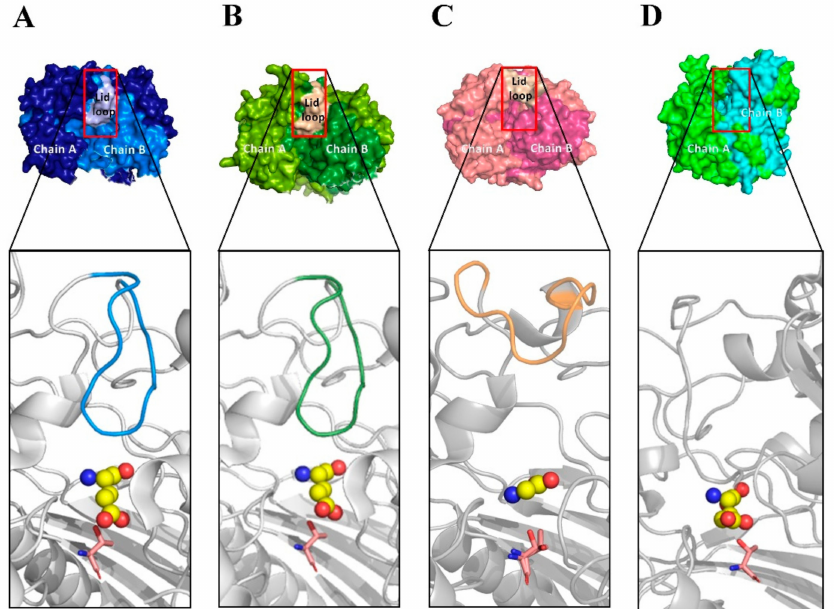
Figure 3. Comparison of the molecular surface and lip loop over the enzymatic pocket of four di ff erent GGT enzymes. The lid loop is colored in blue, green, and yellow; the catalytic threonine is shown as pink sticks; and the enzyme-bound L-glutamate is shown as spheres. Panels: ( A ) Ec GGT